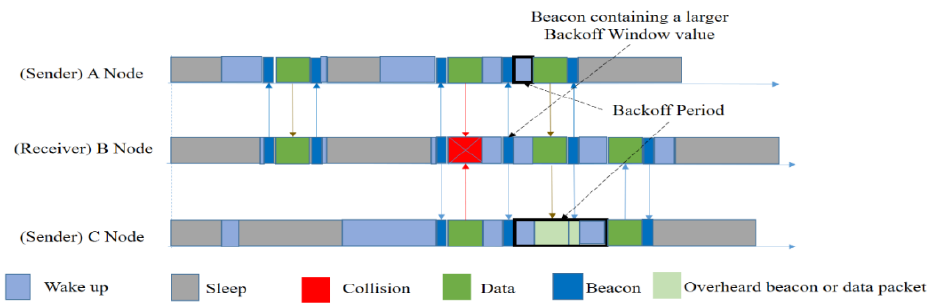
Figure 9. Packet transmission in RI-MAC [32].